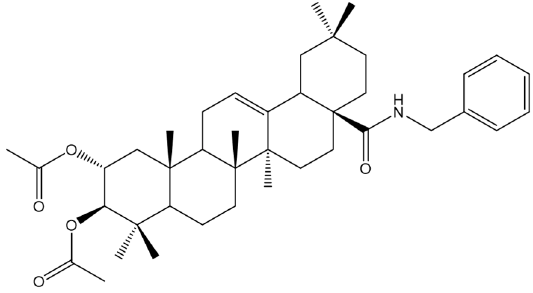
Figure 9. Chemical structure of EM2.